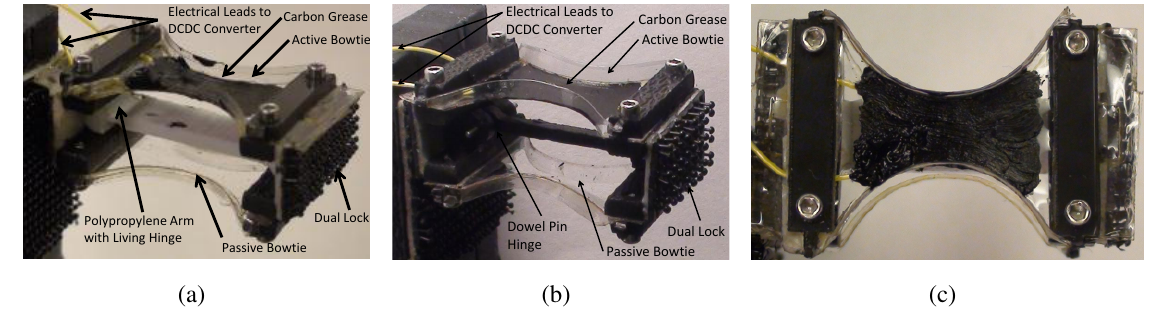
Figure 2. First ( a ) and second ( b ) generation antagonistic bender modules and ( c ) top view of an active bowtie